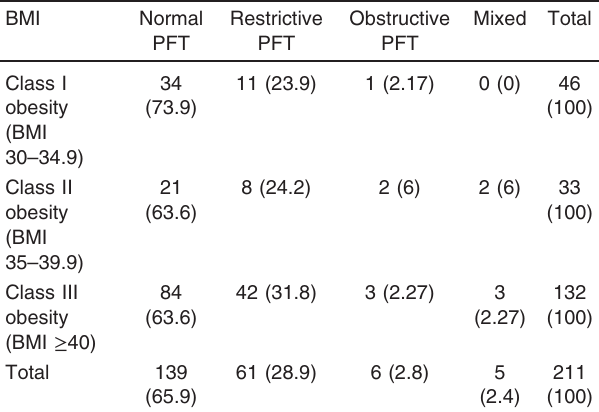
Table 3 Percentage of normal and abnormal pulmonary function test among obese patients BMI Normal